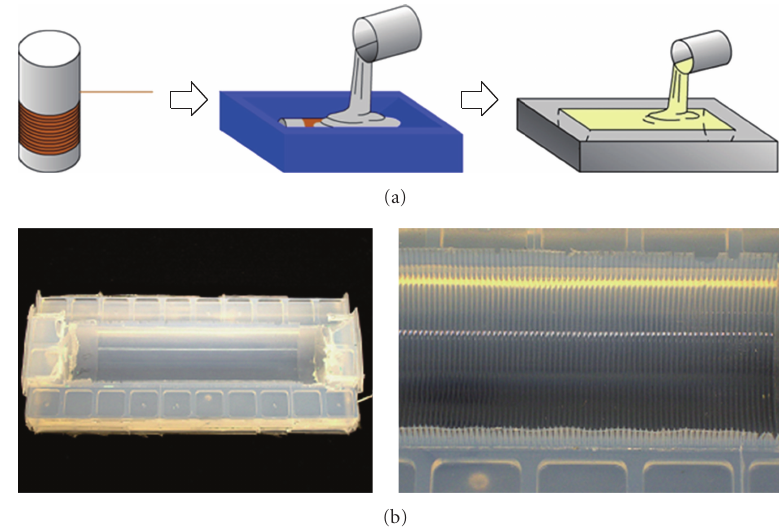
Figure 3: (a) Illustrations showing how a roughness sample is made. (b) Photograph of casting mold.